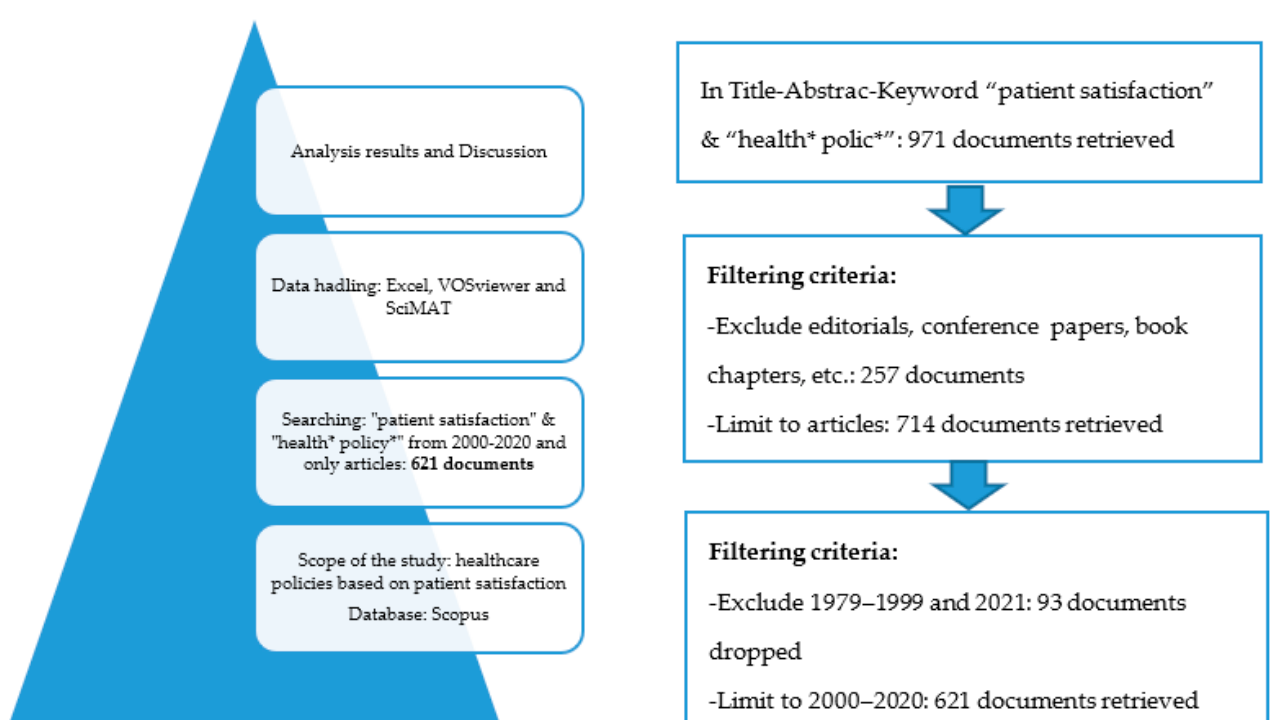
Figure 1. The methodology followed in the selection and processing of information.